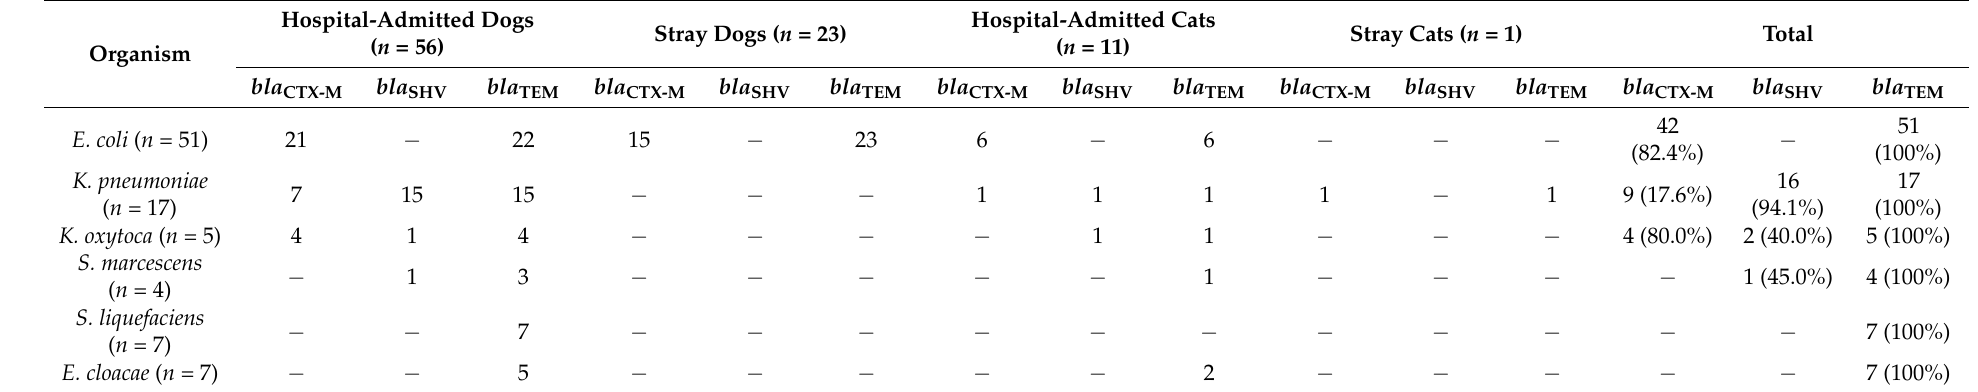
Table 1. Distribution of extended-spectrum β -lactamase (ESBL) genes among 91 Enterobacterales isolates from companion animals.